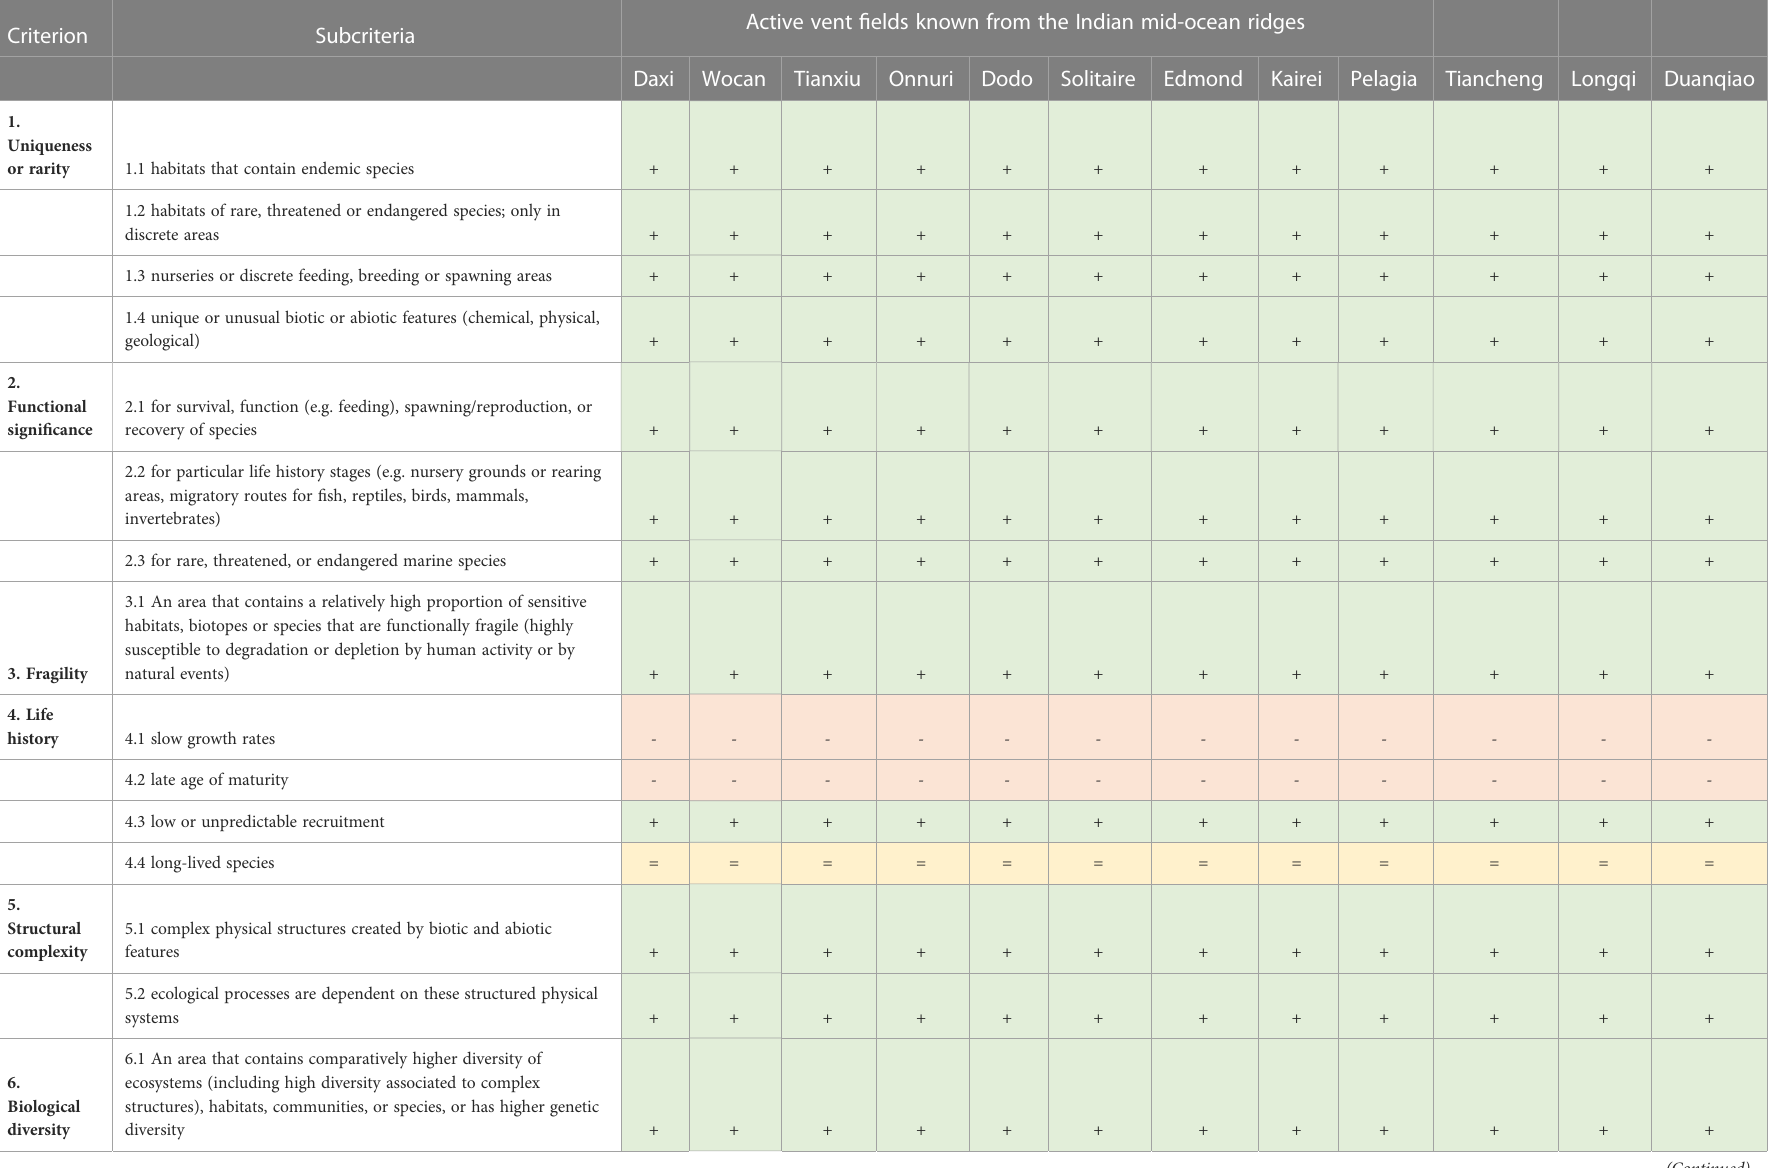
TABLE 2 Application of the scienti fi c criteria for identifying hydrothermal ecosystems in need of protection at 12 Indian vent fi elds, based on the literature used in this review. Criteria de fi nition follows Gollner et al. (2021) (see Appendix 1 , 2 ).